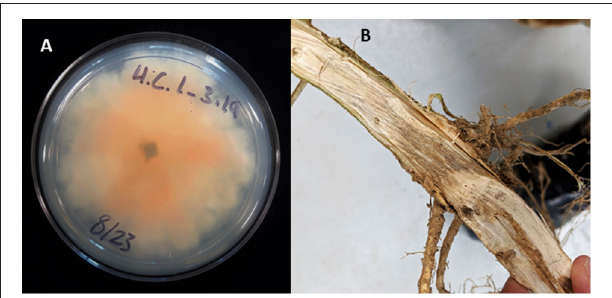
FIGURE 1 | Crown rot in field-grown hemp ( Cannabis sativa ). (A) Culture of Fusarium isolates with culture morphology typical of F. oxysporum ; (B) crown rot caused by Fusarium